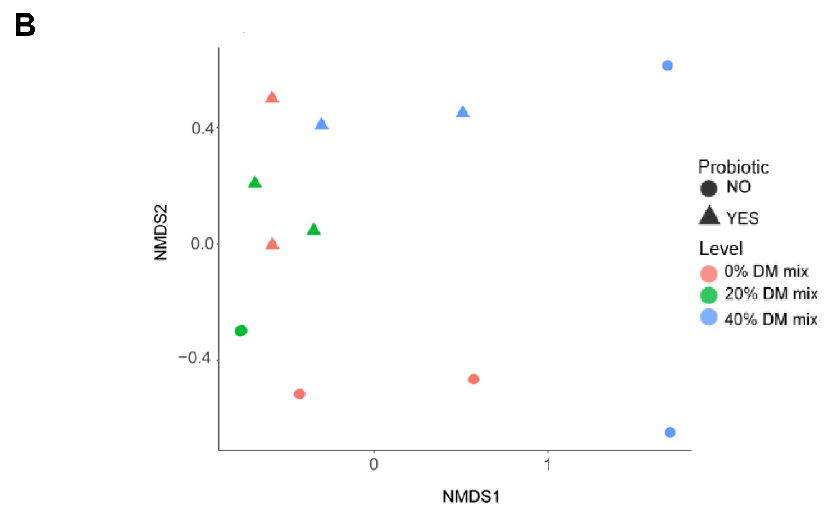
Figure 1. Non-metric multidimensional scaling (NMDS) plot based on the Bray–Curtis dissimilarities of the bacterial and archaeal microbiota of sorghum mixed with 0, 20 or 40% DM vegetable mix after ( A ) 101 d ensiling and ( B ) after 14 d aerobic exposure, with or without a probiotic inoculant.